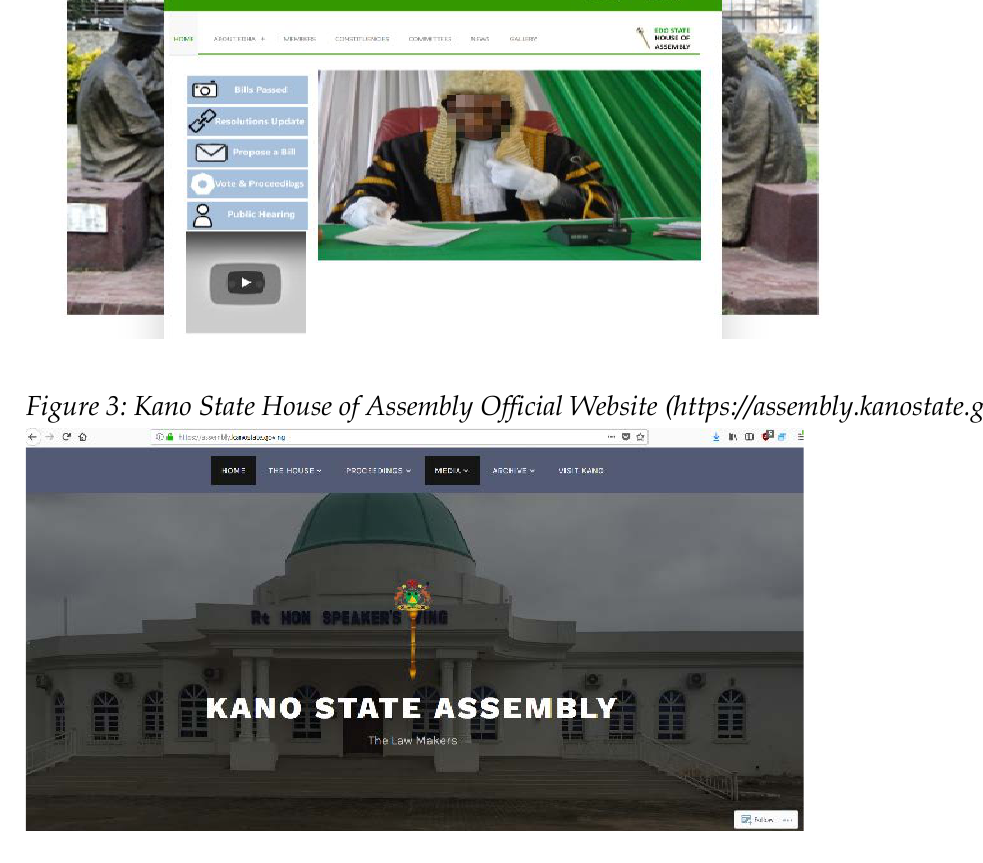
Only the Kano State legislative website, presented in Figure 3, is secured and runs on Hypertext Transfer Protocol (HTTPS) for secure Internet